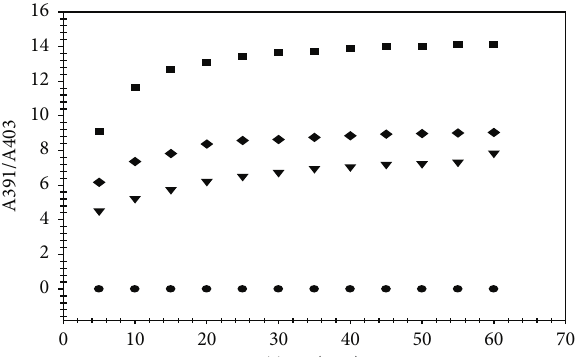
Figure 6: Absorbance ratio of the fabricated silver nanoparticles versus elapsed time in the presence of different concentrations of ammonia: 0ppm ( • ), 1000ppm ( ▼ ), 2000ppm ( ◆ ), 3000ppm ( ◼